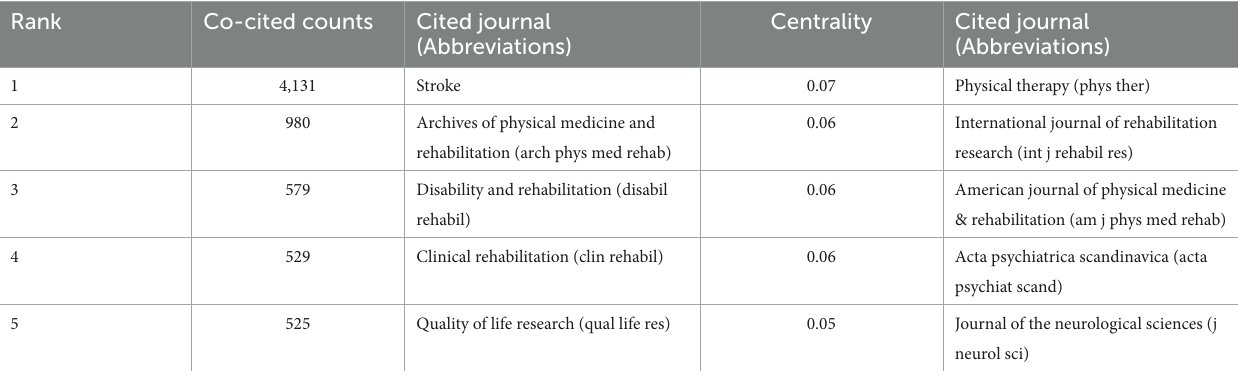
TABLE 3 Top five co-cited journals in terms of counts and